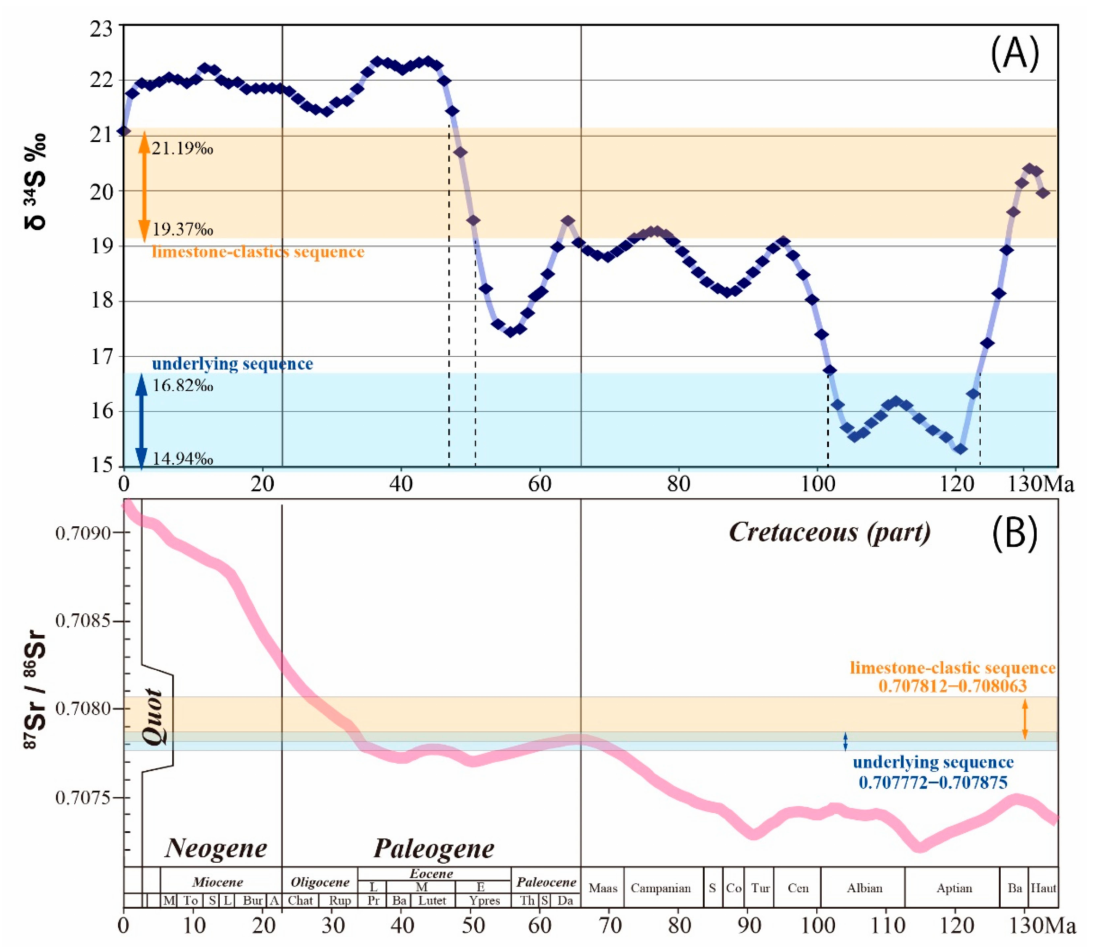
Figure 8. LOWESS curve of the sulfur and strontium isotopic values for the last 130 million years. The sulfur isotopic compositions ( A ) were obtained from [37], while the Sr isotopic compositions ( B ) were obtained from [27,38]. Tangents between the sulfur isotope value obtained in this study and the LOWESS curve allowed for the determination of the geological age ( A